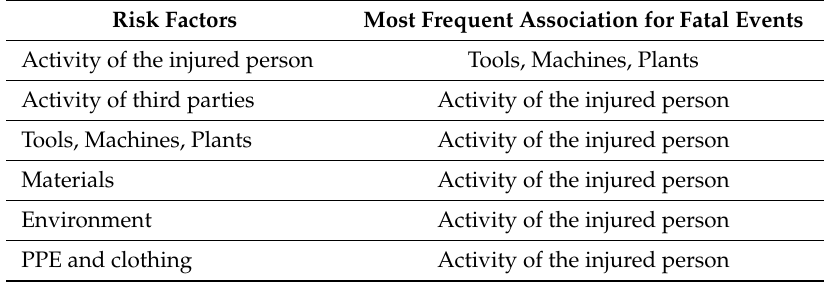
Table 9. Most frequent associations between two risk factors of fatal occupational accidents, by decreasing frequency. PPE, Personal protective